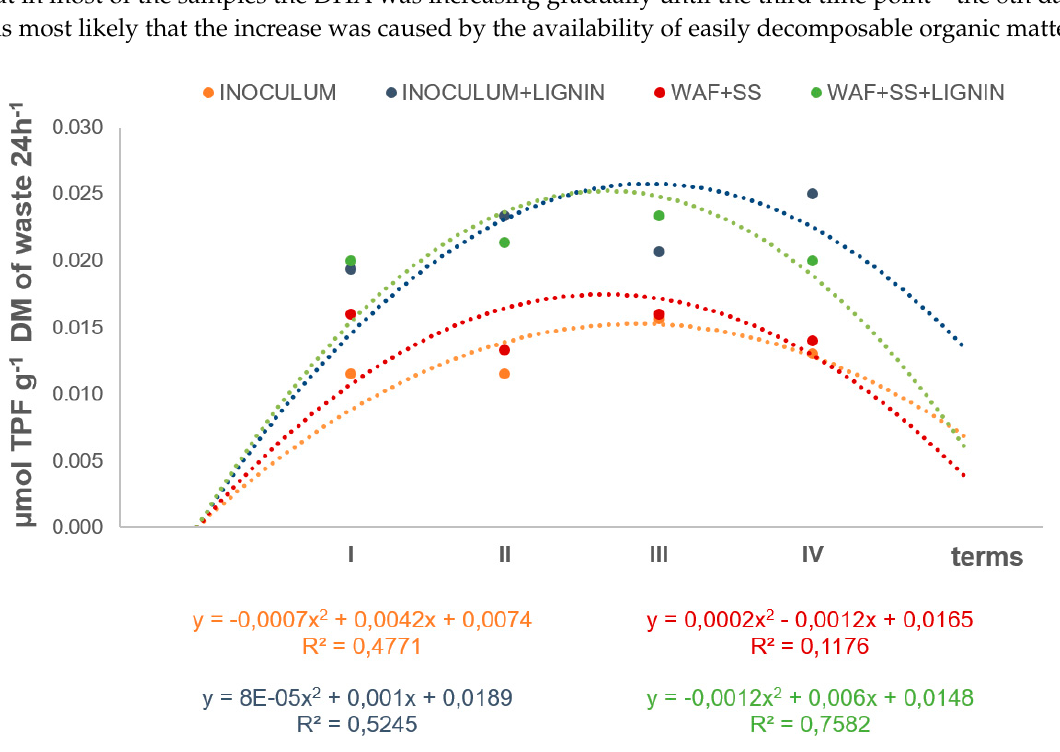
Figure 11. Variation in the dehydrogenase activity (DHA) in the samples subjected to anaerobic